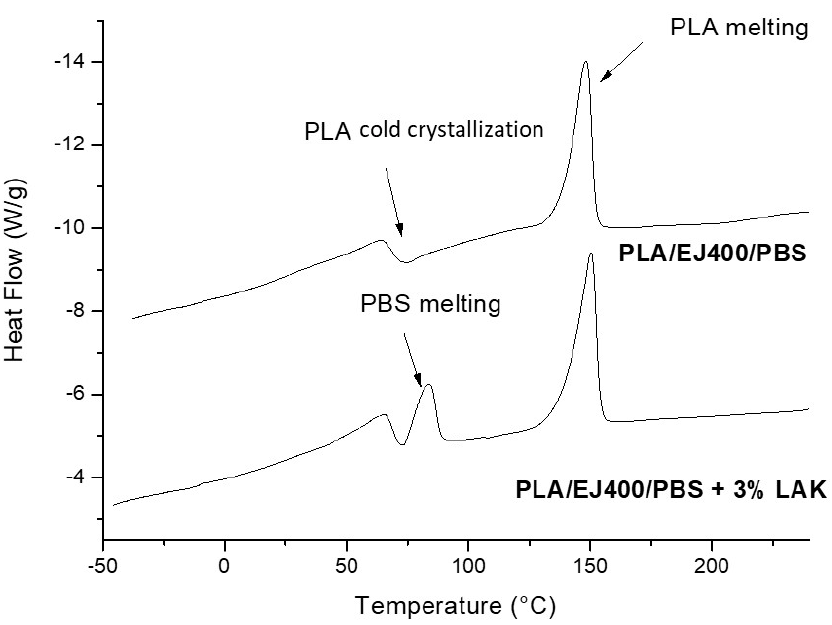
Figure 5. Heating thermogram of a PLA/EJ400/PBS blend and of a PLA/EJ400/PBS blend containing LAK. Table 6. DSC data related to PLA/EJ400/PBS films.